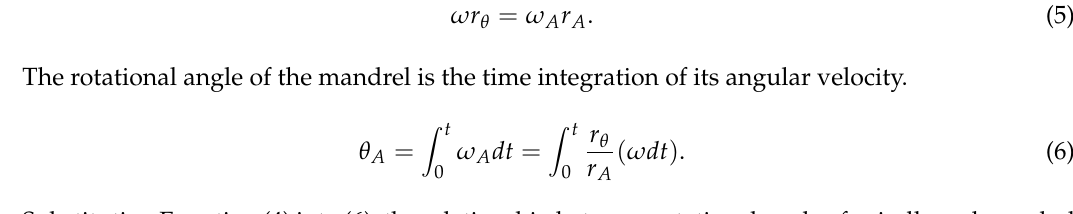
Figure 3. GMM with coaxiality error only: ( a ) θ = 0°; ( b ) θ = 180°.